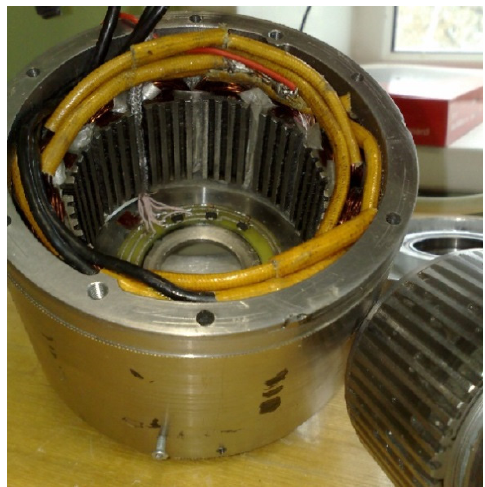
Figure 8. A high-torque inductor-type electric motor.